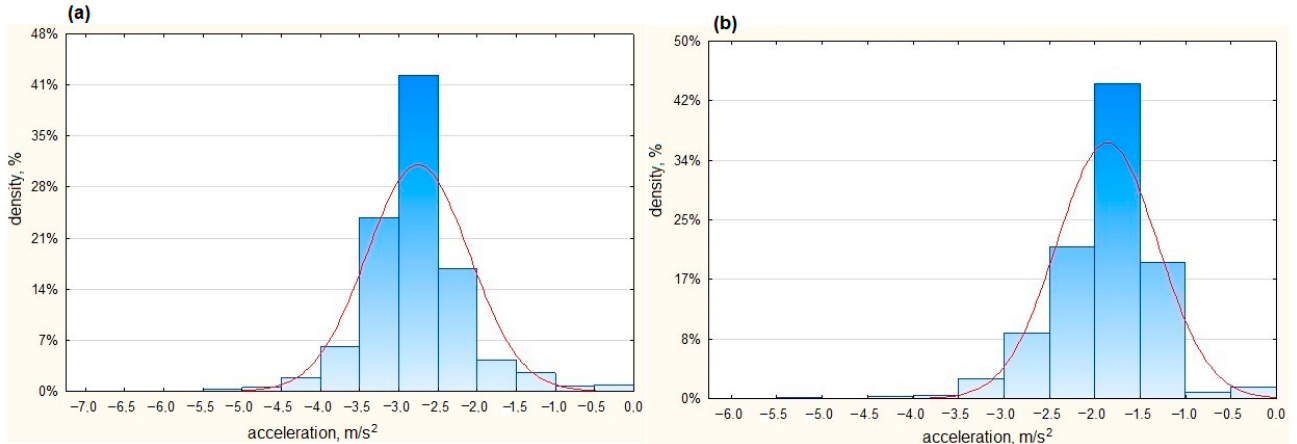
Figure 10. Acceleration recorded during braking in real traffic conditions ( a ) for an urban bus and ( b ) for a coach.